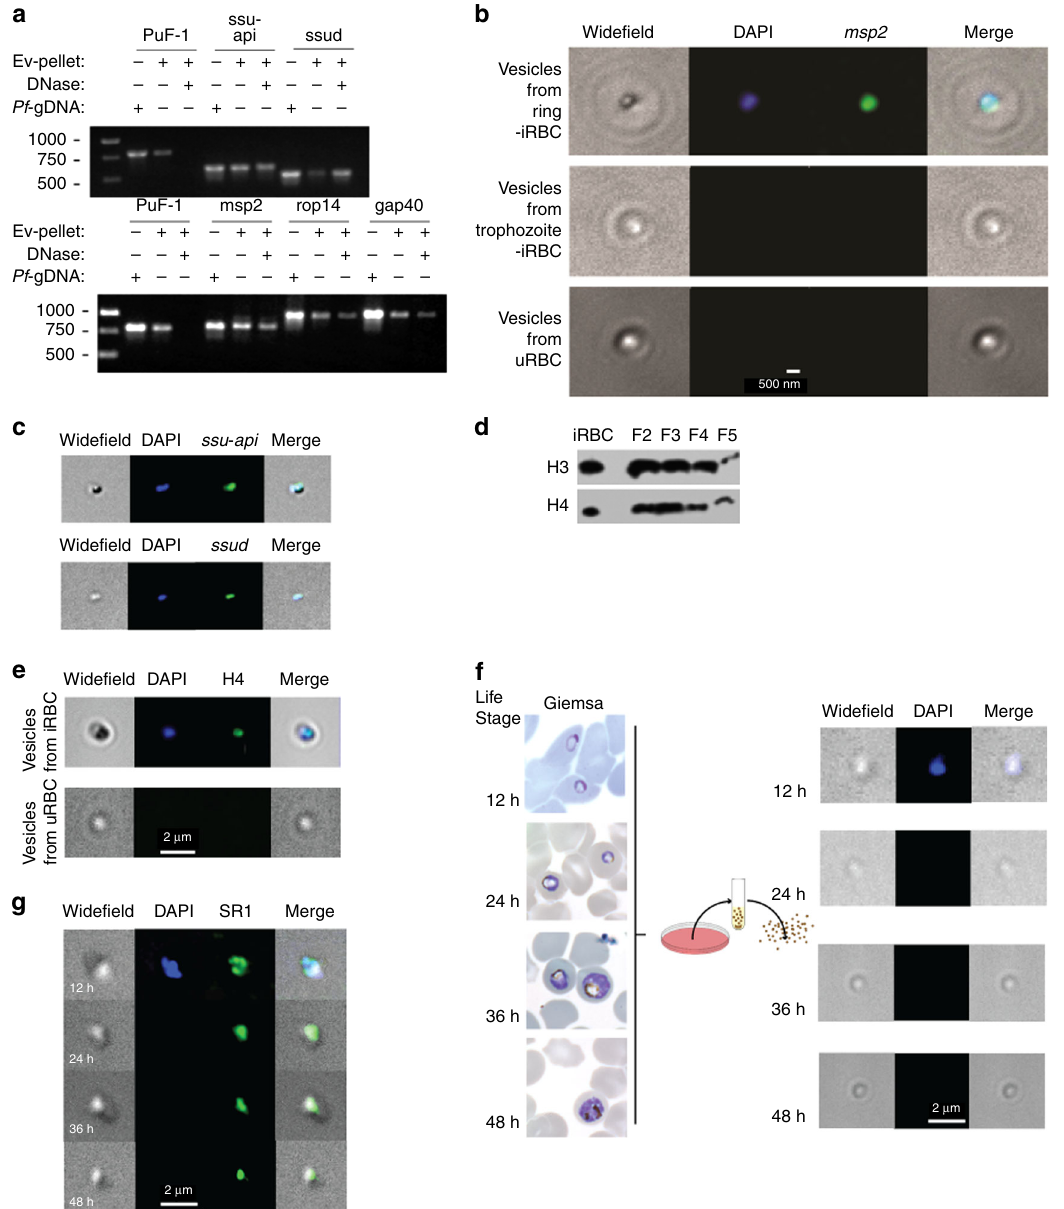
Fig. 4 DNA-binding proteins and mitochondrial and apicoplast genes in EVs. a PCR for Ev-DNA markers, apicoplast ( ssu-api ), mitochondria ( ssud ) and nuclear genes ( msp2 , rap14 , and gap40 ). Plasmid control PuF-1 was added externally to EVs prior to DNase I treatment. b P. falciparum msp2 gene Ev-FISH images of ring and trophozoite EVs and uRBC vesicles. c P. falciparum ssu-api and ssud genes Ev-FISH of ring EVs. d H3 and H4 protein WB analysis for 2 – 5 OP gradient fractions (F). e P. falciparum H4 protein IFA. f P . falciparum parasites release EVs during the early post-invasion phase. Fluorescence microscopy using DAPI in EVs produced by iRBCs across their life cycle. Images of EVs collected at 12, 24, 36 and 48 h post invasion. Giemsa stains ( fi rst column) show the state of the parasites prior to collecting EVs at each time point. g SR1 control